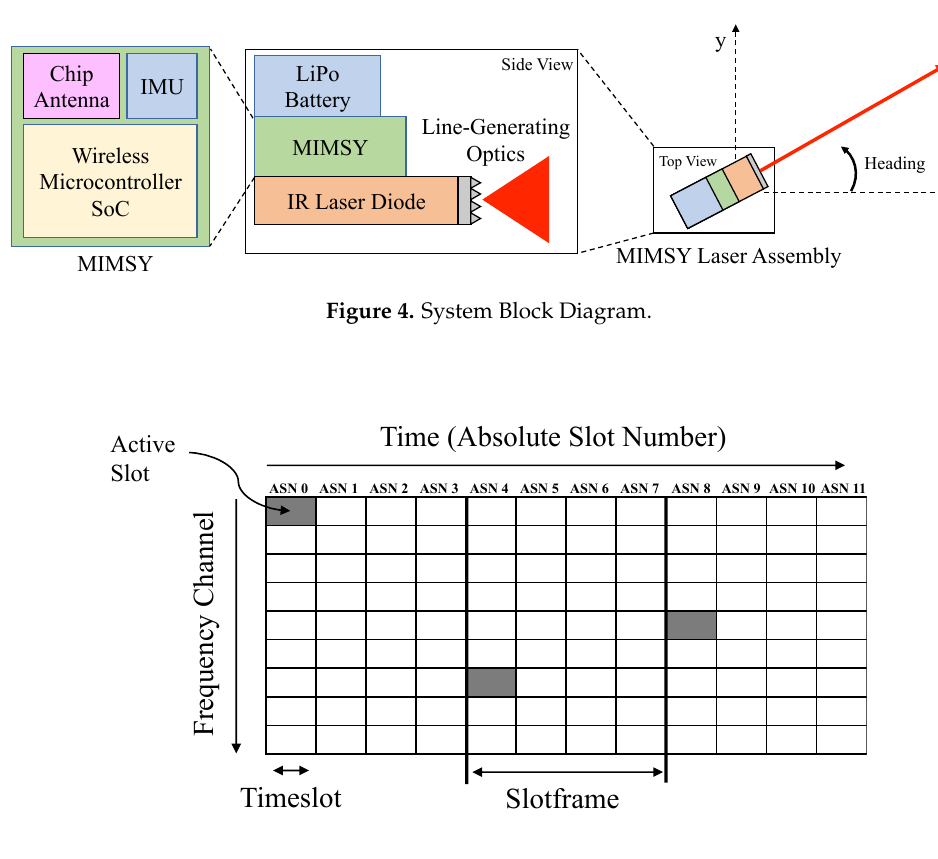
Figure 5. Time-synchronized channel hopping (TSCH) matrix for OpenWSN. Timeslots in the TSCH matrix correspond to points in time and frequency and can be scheduled as active and inactive. Active slots can be used for transmitting or receiving packets, while inactive slots are used for saving power. All the motes in a TSCH network must maintain a common synchronized sense of time in order for this network architecture to operate. The absolute slot number (ASN) reflects the current network-wide time in units of timeslot, which are 10 ms long in this application. This universal timebase enables infrastructure-free lighthouse